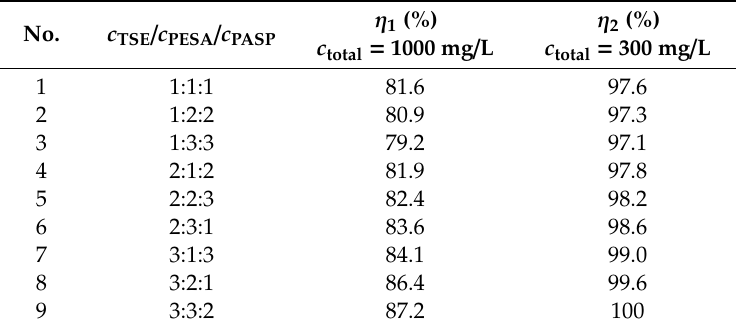
Table 2. The corrosion ( η 1 ) and scale ( η 2 ) inhibition rates of ternary compound formula (60 ◦ C). No.